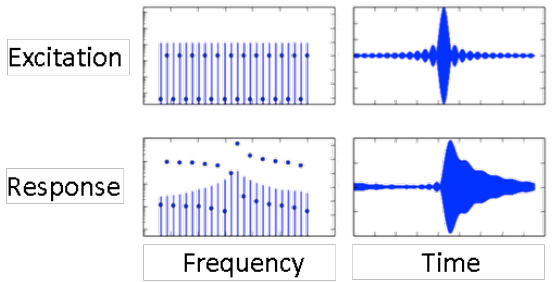
Figure 6. Excitation and response of a resonator in the frequency domain and the time domain as determined with the MLA. The instrument applies a comb of up to 32 frequencies. The current response shows the resonance curve ( bottom left ). Transformed to the time domain ( right ), the excitation amounts to a sequence of pulses with a spacing in time of 1/( ∆ f comb ). The response is similar to a ring-down process ( lower right ). Downloaded from www.intermodulation-prod- ucts.com/applications/lock-in on 13 February 2019.